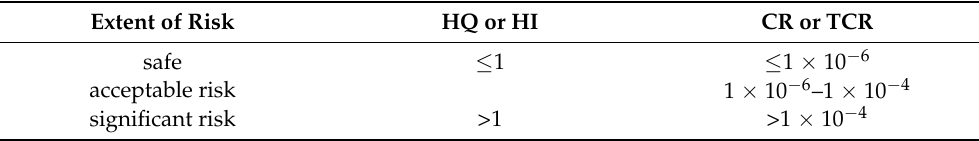
Table 4. Health risk assessment